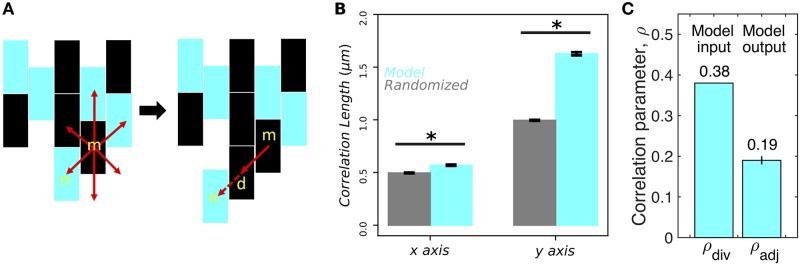
Mechanistic model of correlated signaling captures experimental features.(A) Mother cell (m) produces daughter cell (d) with correlated signaling state at any neighboring site at which a maximum of one neighbor cell (n) is displaced. Cyan indicates that cell has the ability to signal. (B) Correlations are significantly longer than random both perpendicular (x) and parallel (y) to the signaling direction (N = 104 lattices; p < 0.001 for both assuming Gaussian errors). Compare to experiments in Fig 1D. (C) Stochasticity in division times, neighbor selection, and cell displacement reduces correlation parameter from ρdiv = 0.38 to ρadj = 0.19 ± 0.01, close to experimentally measured ρadj = 0.17 (N = 104 lattices).